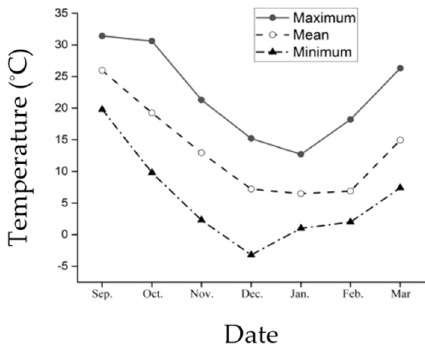
Figure 1. Seasonal change in maximum, mean and minimum ambient temperatures in the Huai’an area between September 2020 and March 2021.